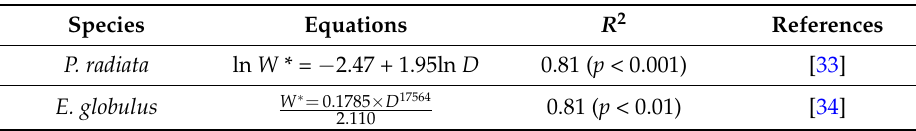
Table 4. Allometric equations to estimate the potential residual forestry